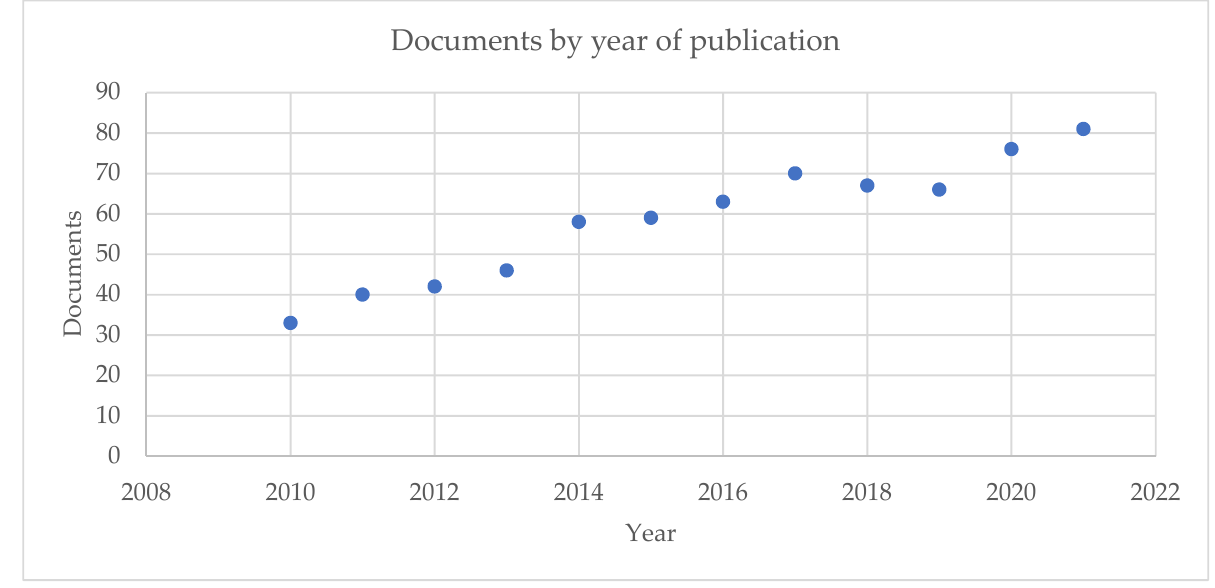
Figure 3. Documents by year of publication.